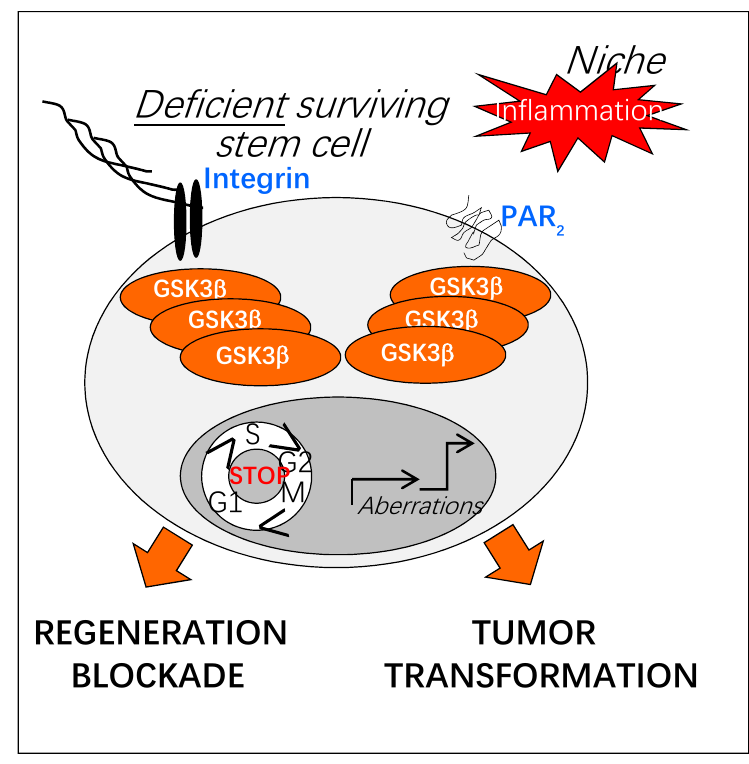
Figure 5. Potential impact of prolonged GSK3 β activation on regenerative functions of adult stem cells. Upon chronic inflammation, increased activation of GSK3 β could result in a deregulation of the regenerative properties of adult stem cells (defect in tissue repair, tumor transformation). As sensors of the injured stem cell niche, adhesion and protease-activated receptors (Integrins, PARs) could play a crucial role in the sustained activation of GSK3 β